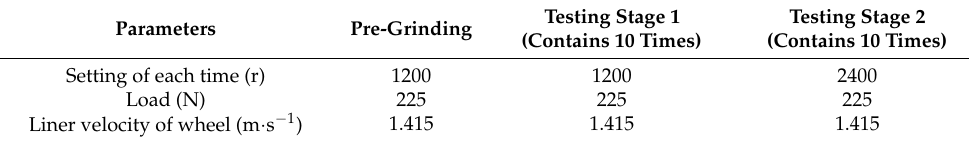
Testing Stage 1 Testing Stage 2 (Contains 10 Times) (Contains 10 Times)